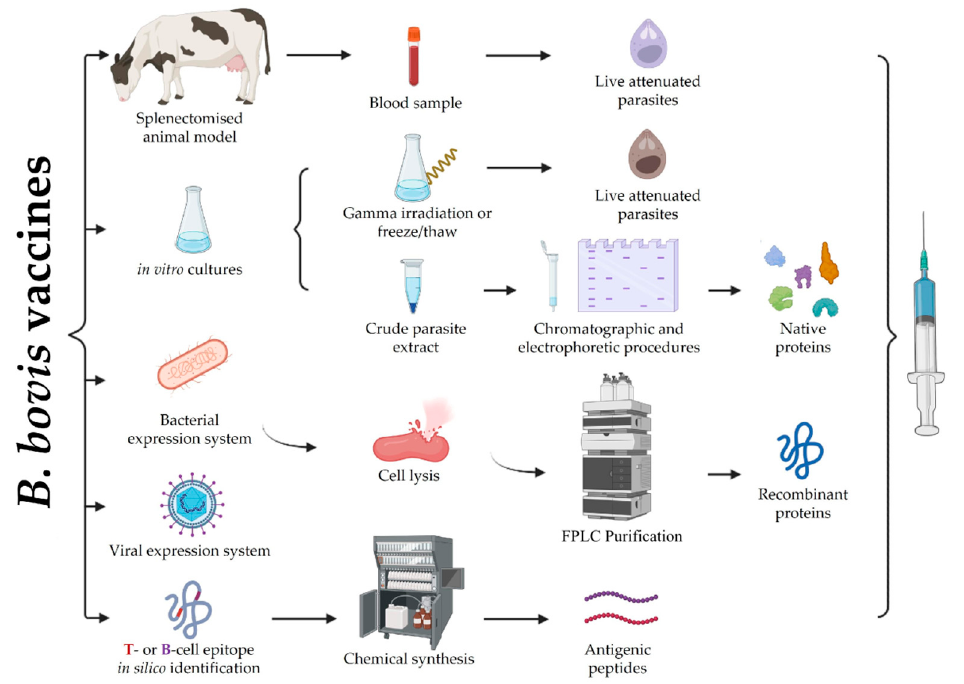
Figure 2. B. bovis vaccine design. The figure summarises the different anti- B. bovis vaccine types developed to date. Live attenuated vaccines are obtained by successive parasite passages in splenectomised cattle or in vitro cultured parasites that are subsequently attenuated by different methods. Protein-based vaccines have been obtained by size separation of crude parasite extracts, recombinant expression in E. coli and subsequent lysis and purification by affinity chromatography, or viral vectors engineered to express the protein if interest in vivo. Peptide-based vaccines are focused on the in silico identification of short regions containing B- or T-cell epitopes and subsequent chemical synthesis. Figure created with